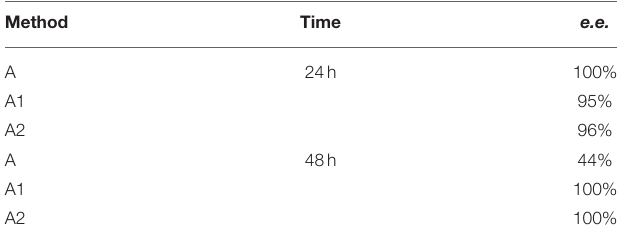
TABLE 1 | Results of biotransformation of the racemic mixture of 1-amino-1(2-thienyl)methylphosphonic acid (substrate 1 ) with fresh, wet biocatalysts cells.